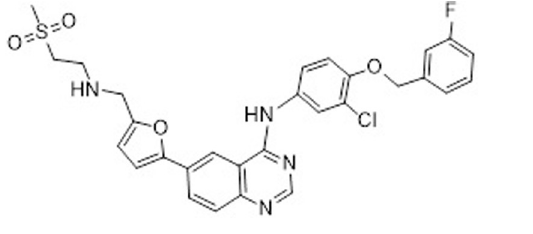
Fig 1. Chemical structure of lapatinib